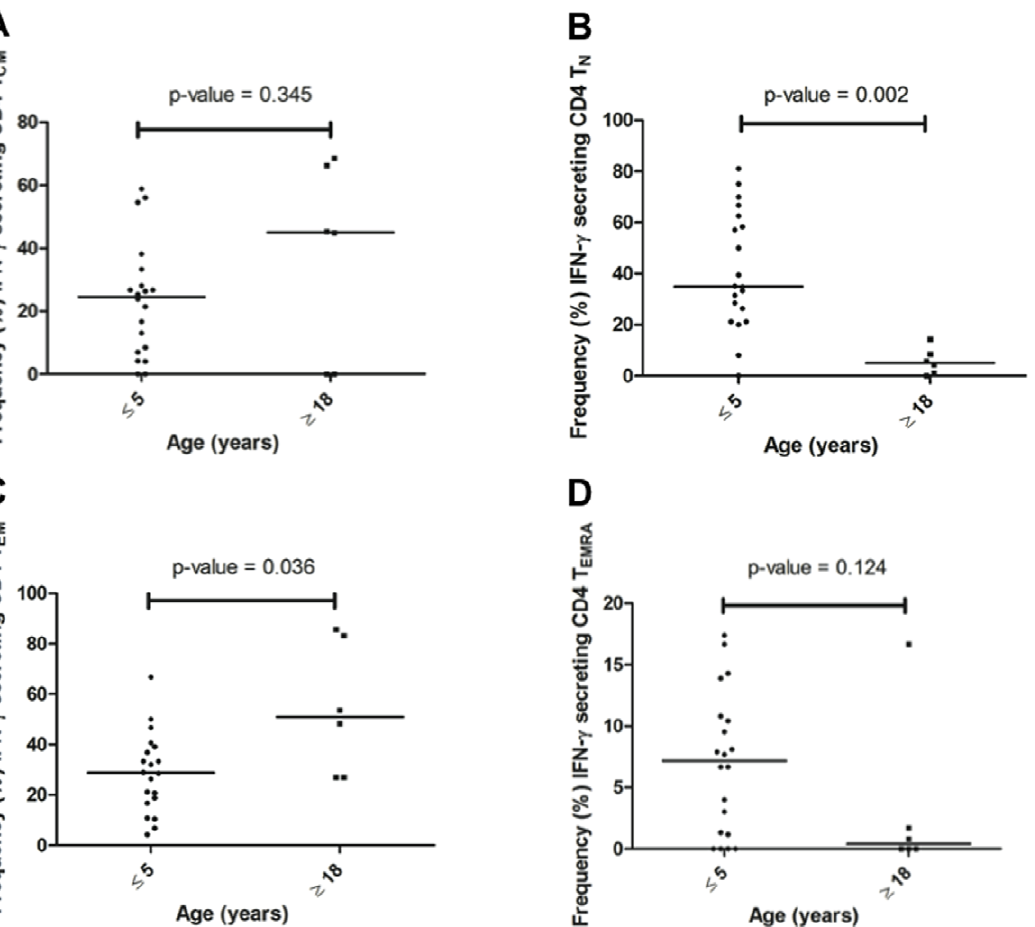
Figure 6. Proportion of MSP1 42 -specific IFN- c secreting CD4 + T cell subsets across age groups. As described above, IFN- c responses to MSP1 42 (3D7 strain) were determined ex vivo by intracellular staining and flow cytometric analysis of cell surface marker expression. T cell subsets were defined by expression of CD45RA and CD62L surface markers: ( A ) T CM (CD4 + , CD45RA 2 , CD62L + ); ( B ) T N (CD4 + , CD45RA + , CD62L + ); ( C ) T EM (CD4 + , CD45RA 2 , CD62L 2 ); and ( D ) T EMRA (CD4 + , CD45RA + , CD62L 2 ). The phenotype of IFN- c expressing CD4 + T cells in adults were predominantly T CM and T EM compared to the children who had IFN- c expressing CD4 + T cells generated from all four subsets including those phenotypically T EMRA and T N . Significant differences (Mann Whitney test) in median frequencies were observed for CD4 + T EM subsets, which were more prevalent ( P -value=0.036) and CD4 + T N , which were less prevalent ( P =0.002) in adults compared to children. Differences observed in the frequencies of CD4 + T CM and T EMRA between age groups did not reach significance due to small sample size.